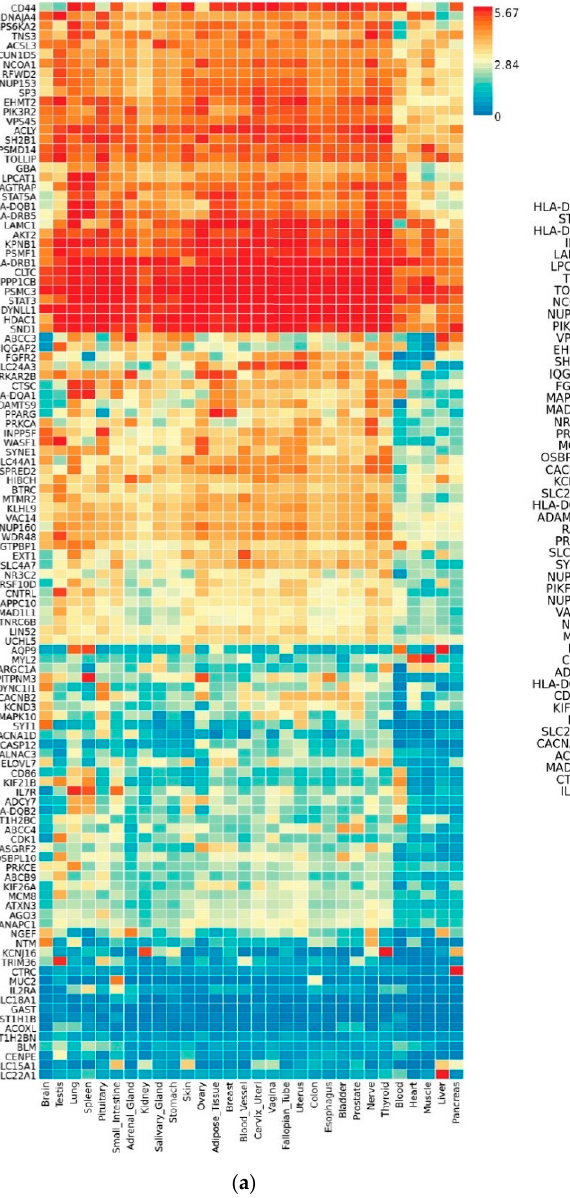
Figure 3. Human gene expression heatmap of MAGMA and VEP genes of COVID-19-associated comorbidities. Functional Mapping and Annotation of Genome-Wide Association Studies (FUMA GWAS) GENE2FUNC online tool was used to create a heatmap showing differential gene expression datasets using log2 transformed expression values from ( a ) Heatmap of MAGMAv1.07b significant genes. A total of 118 STRING significant genes were identified ( p < 0.05) via MAGMAv1.07b and ( b ) the heatmap of 50 VEP matched genes from Ensembl Variant Effect Predictor (VEP) using ( a , b ) Genotype-Tissue Expression (GTEx) v8 representing 30 general tissue types. Red cells depict higher expression compared to cells filled in blue and yellow represents expression that is not significantly different from other genes.